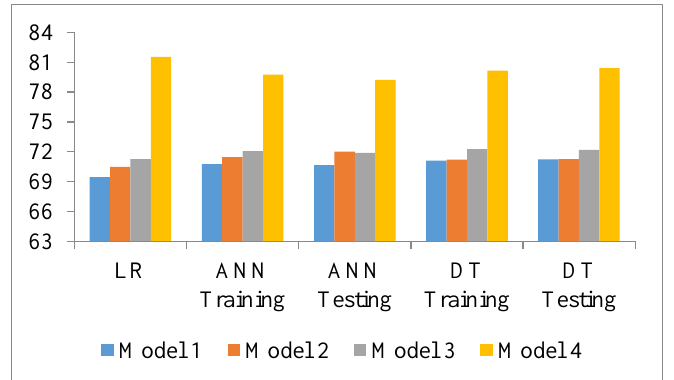
Figure 5. Specificity comparison of Logistic Regression, Artificial Neural Networks and Decision Tree